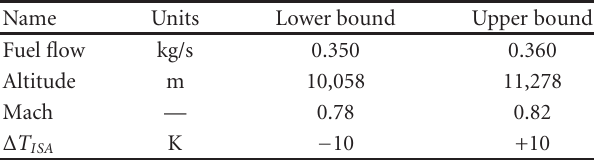
Table 2: Operating